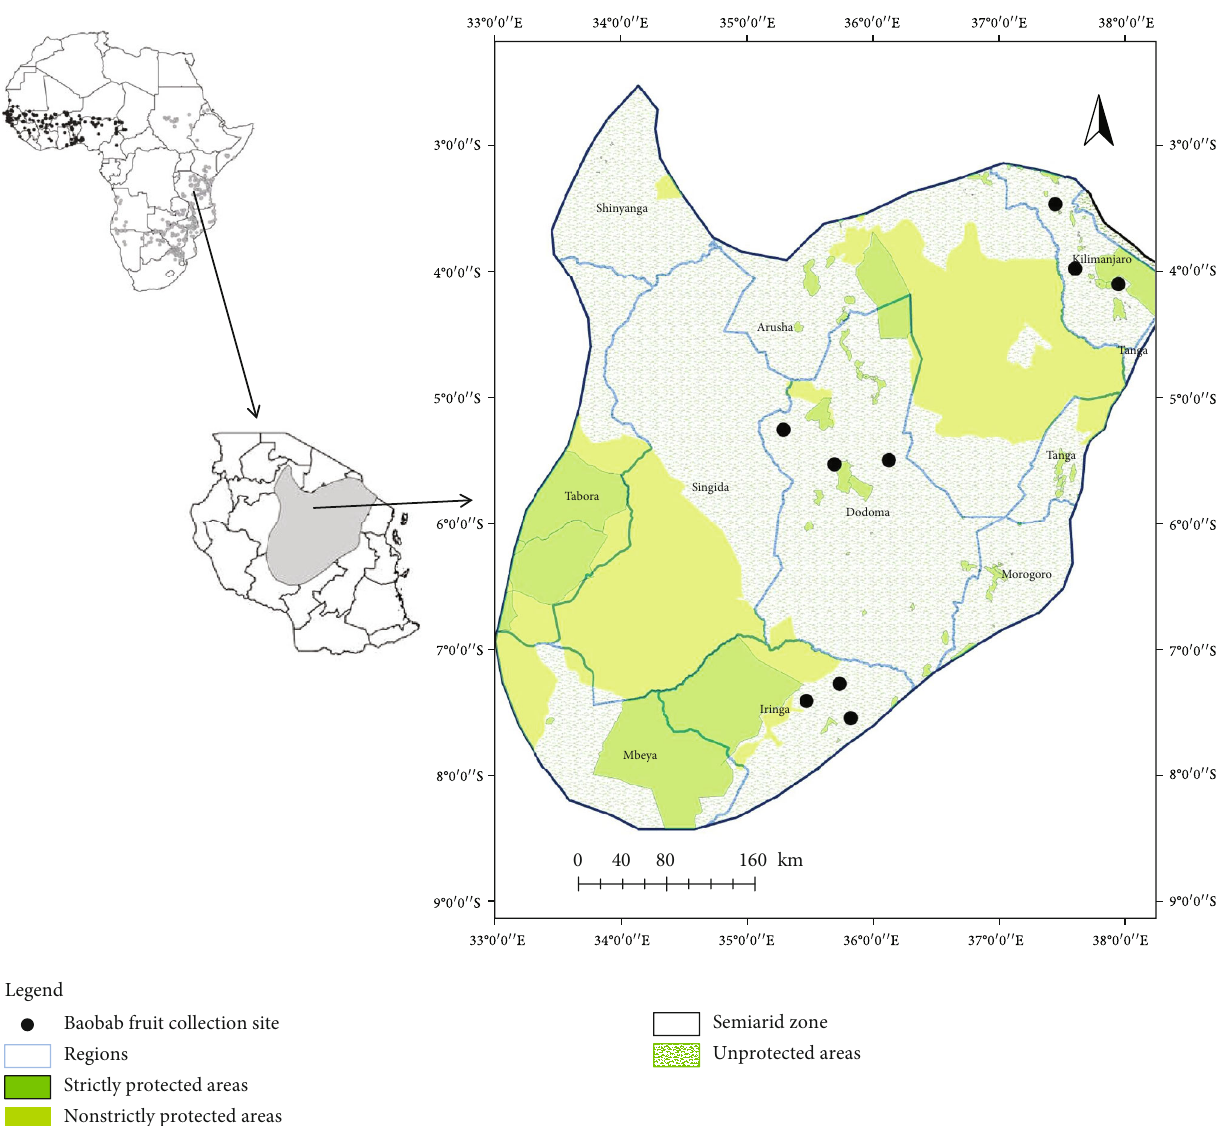
Figure 1: Map showing the location of the study area in Tanzania. Table 1: Geographical location and environmental conditions of regions where baobab fruits were collected.